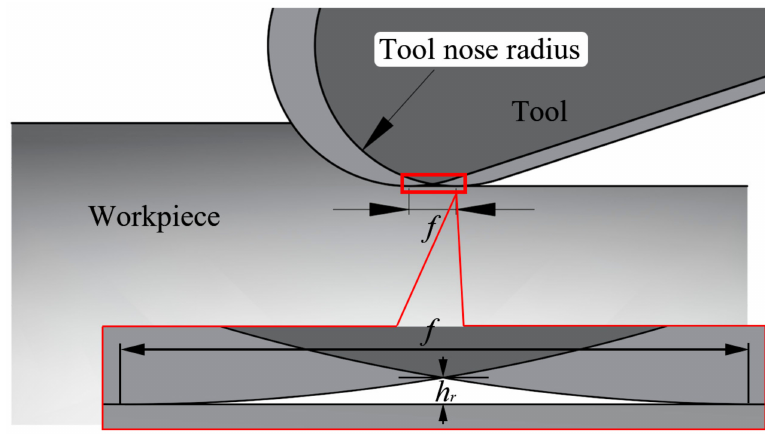
Figure 13. The schematic diagram of cutting residual